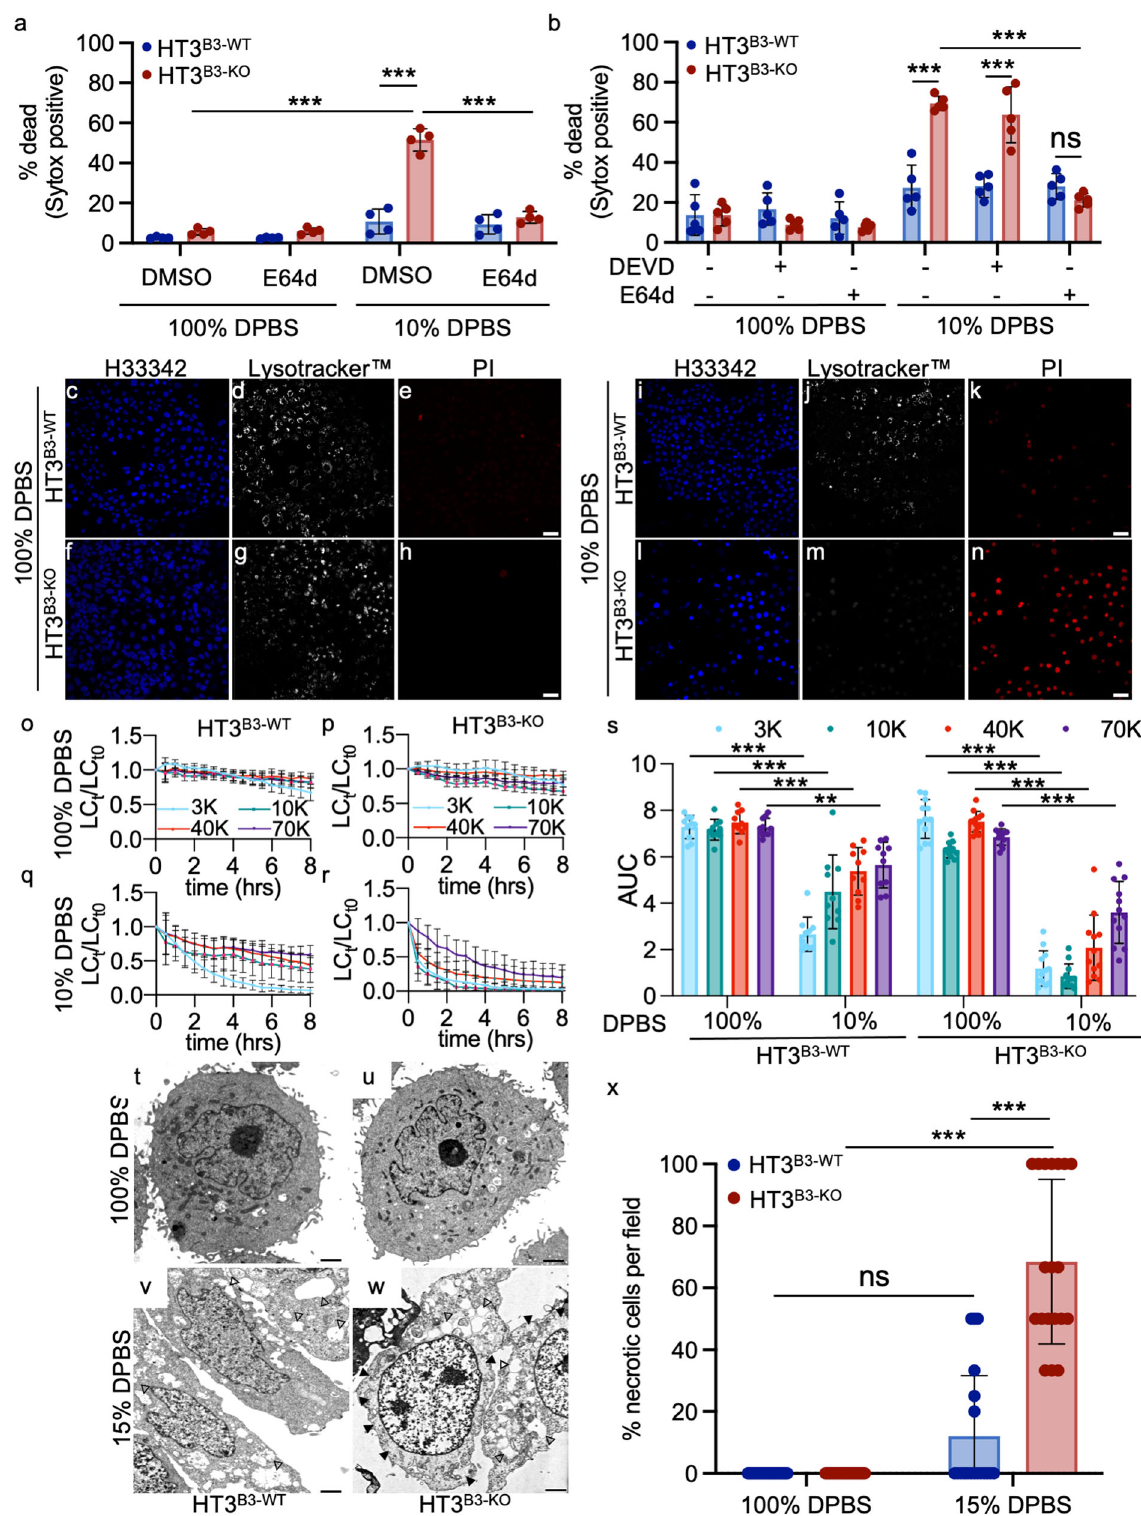
Ferroptosis . Reactive oxygen species (ROS) generated by the iron- dependent Fenton reaction, depletion of glutathione, and lipid peroxidation result in ferroptosis. Morphologically ferroptosis is distinguished by mitochondrial condensation, increased membrane density and lost cristae 75 . Ferroptosis is triggered by either erastin or